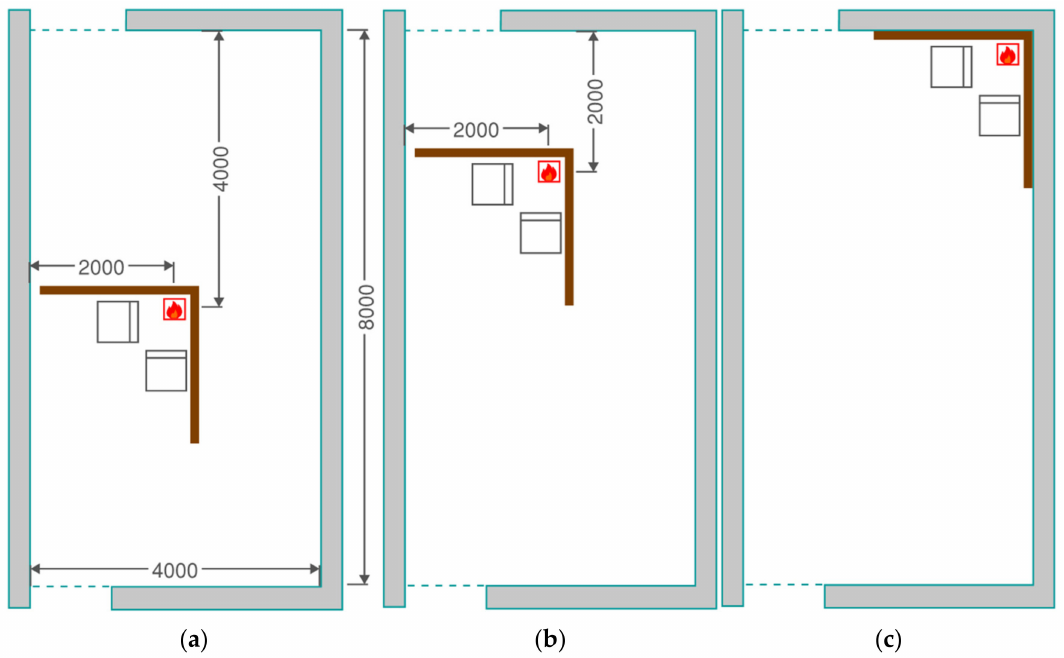
Figure 4. Fire locations for the tests: ( a ) centre 1 [A-02, A-04, A-06 and A-09]; ( b ) centre 2 [A-03, A-07, and A-10]; and ( c ) corner [A-01, A-05, A-08, and A-11]. All dimensions in